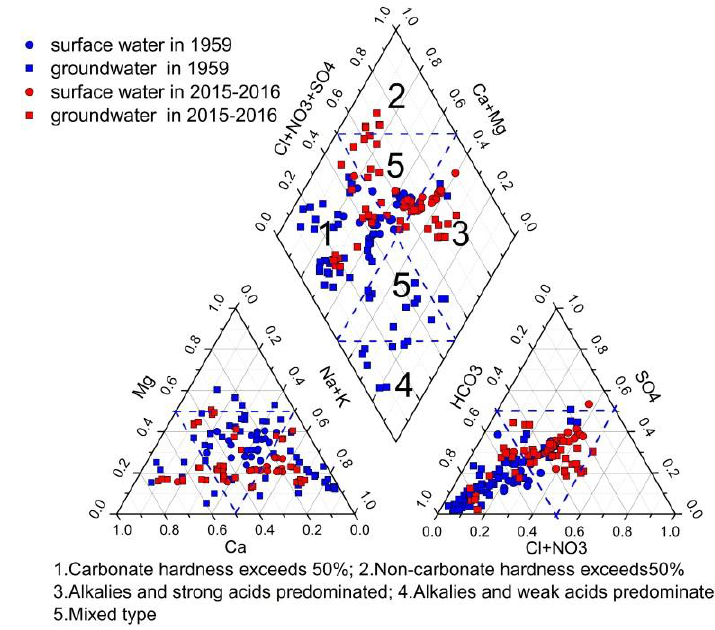
Figure 5. Piper plot for the SW and GW samples.